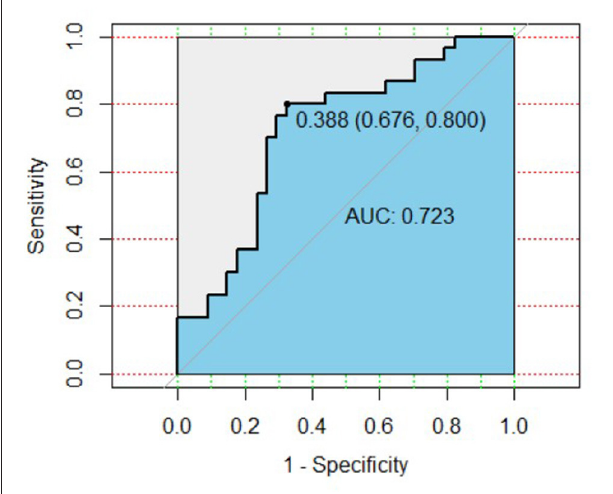
FIGURE 1 | ROC curve of plasma CEACAM-1 combined with NrCAM for the diagnosis of MDD. AUC, area under the ROC curve; ROC, receiver operating